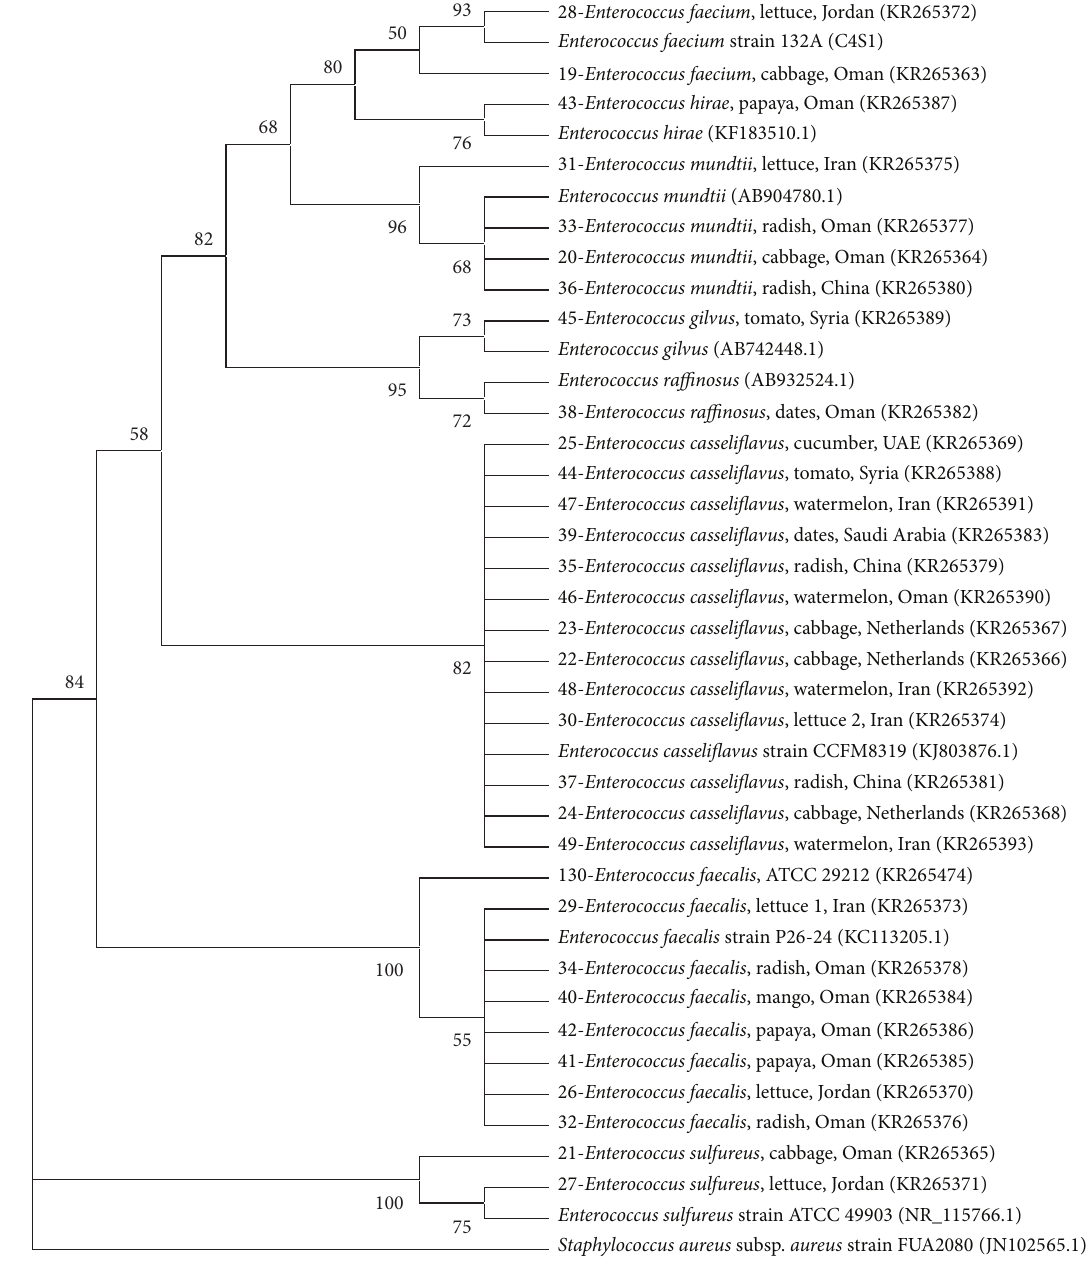
Figure 5: Neighbor joining tree based on sequencing 16S rRNA gene for members of Enterococcus isolated from fresh produce. Staphylococcus aureus (JN102565) was included as an outgroup. KR-accession numbers correspond to gene sequences that belong to isolates analyzed in this study while others were obtained from NCBI database. Bootstrap values above 50% are shown (1000